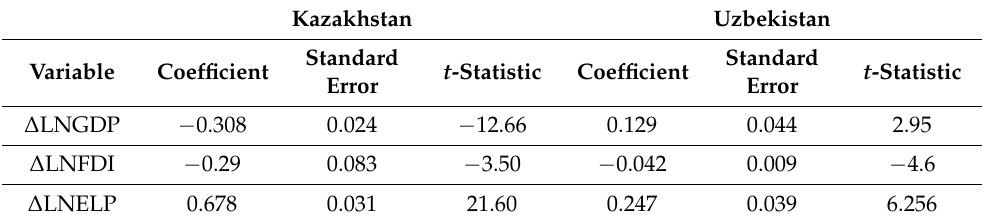
Table 5. Vector Error Correction models.